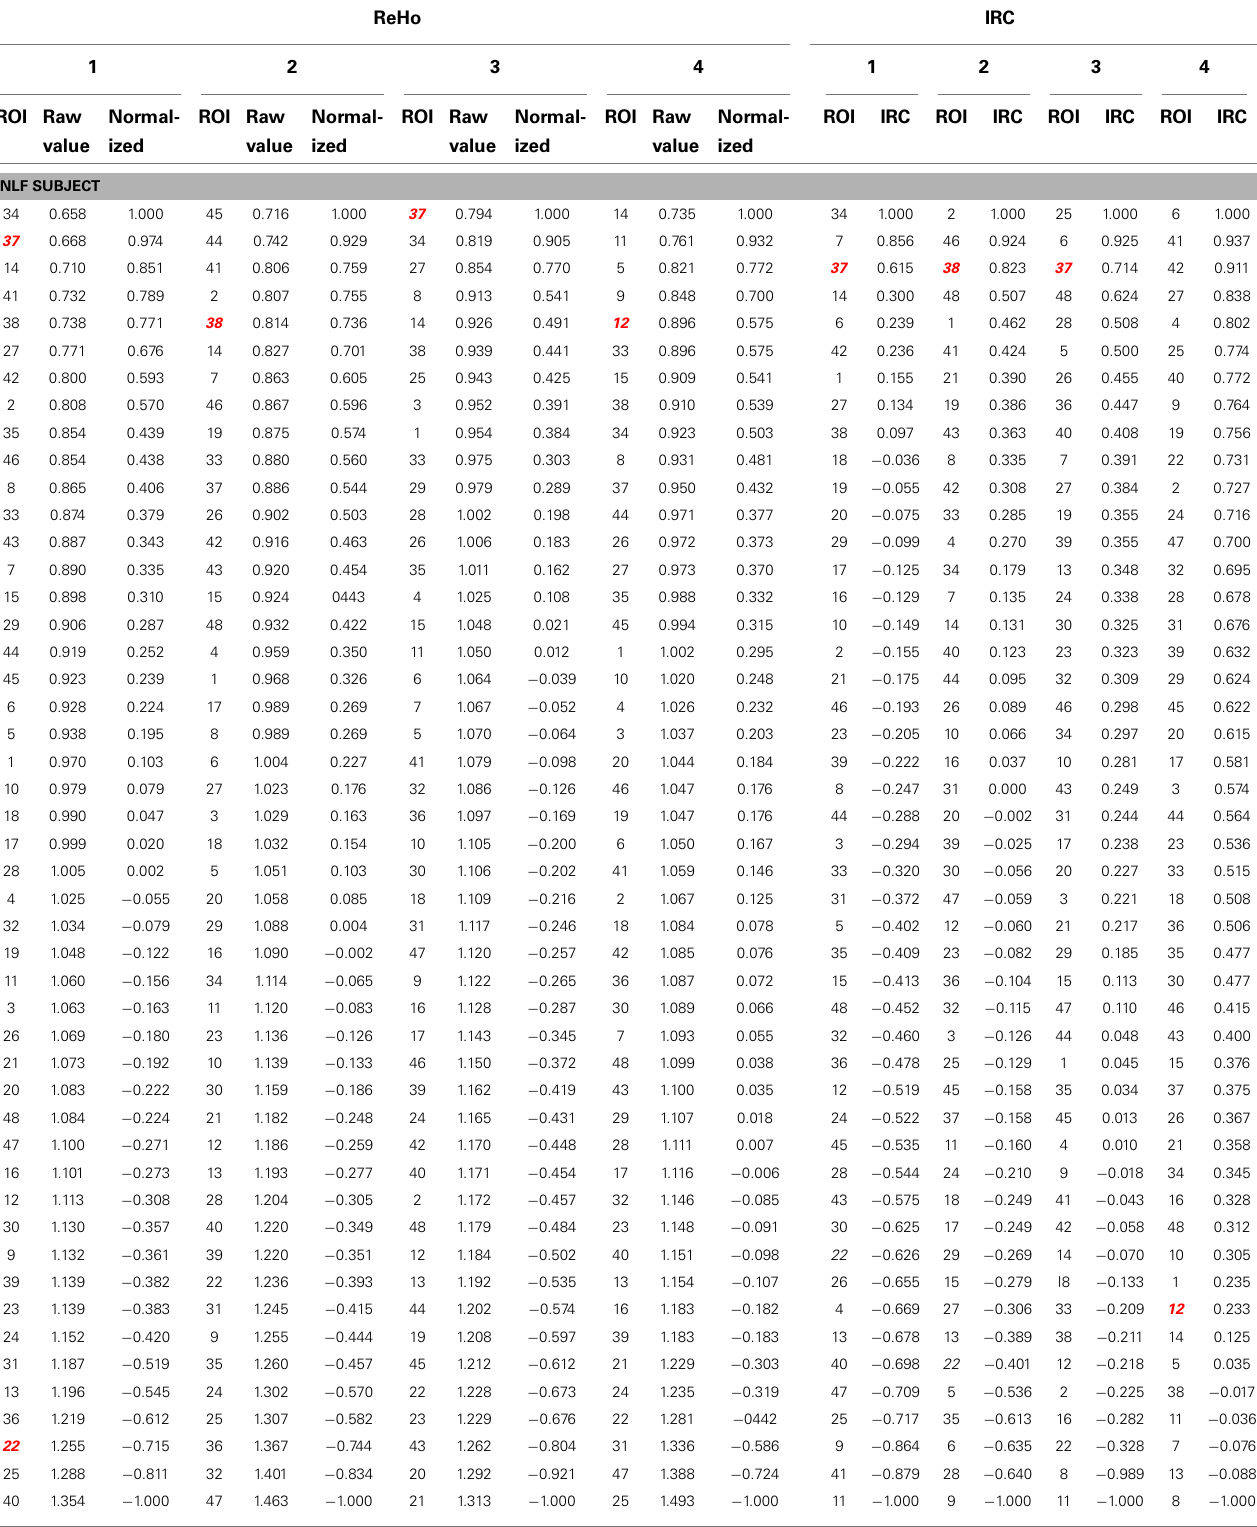
Table 2 | ReHo, IRC and mean ranking values for all HO